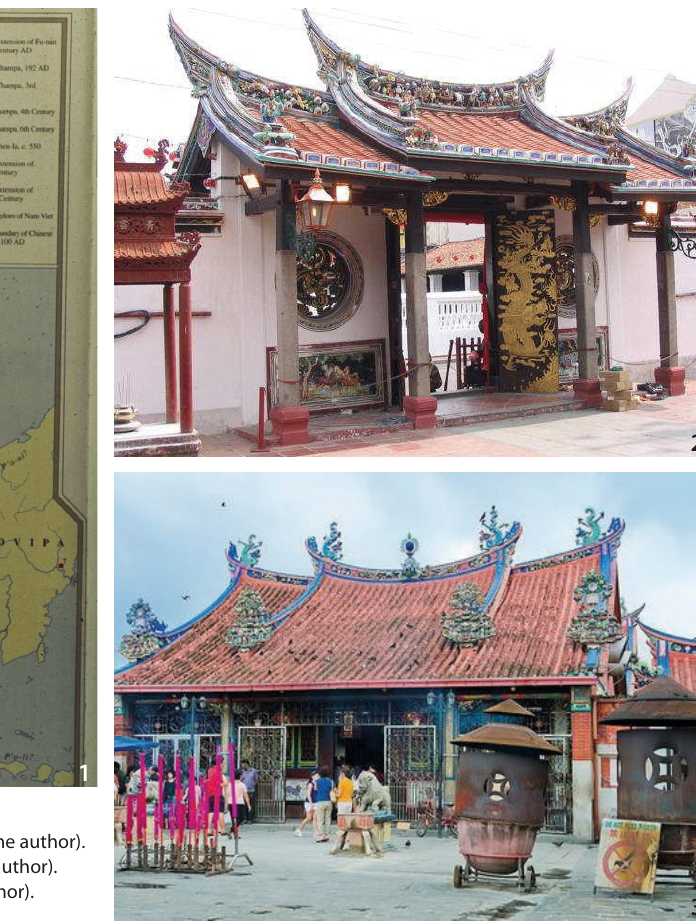
Figure 1 Map of Malacca Straits in Southeast Asia (Source: the author). Figure 2 Cheng Hoon Teng temple in Malacca (Source: the author). Figure 3 Guang Fu Gong temple in Penang (Source: the author).